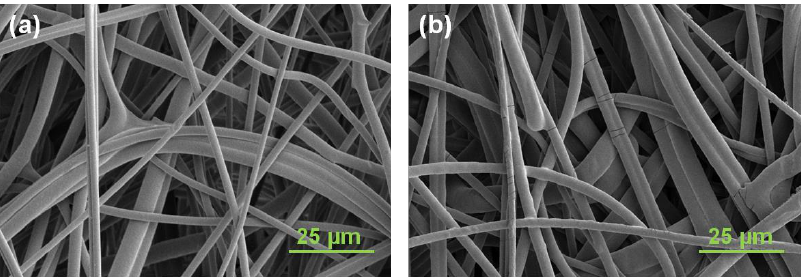
Figure 3. SEM images of the membrane surface for ( a ) pristine PBT membrane and ( b ) final CEX